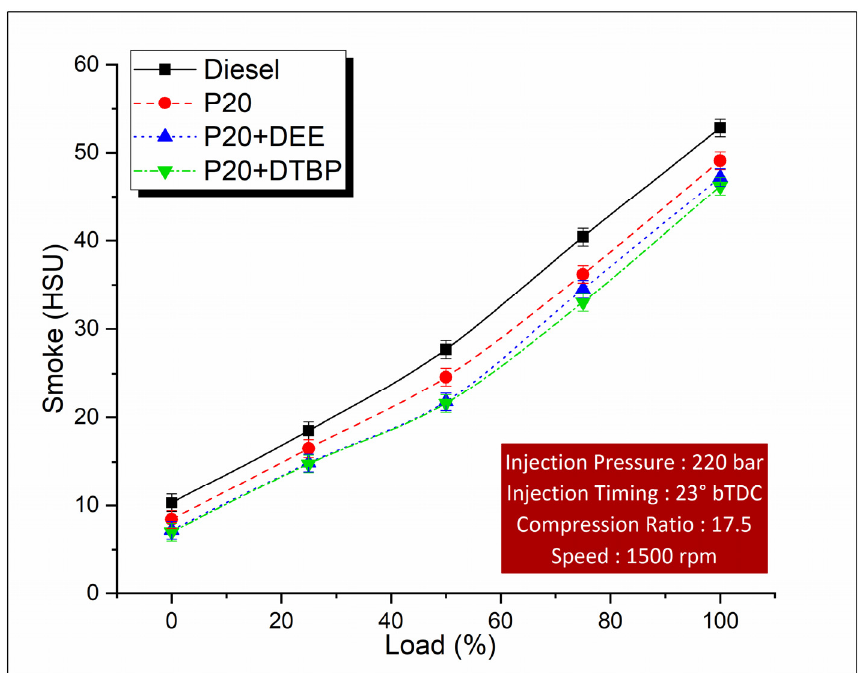
Figure 10. Smoke variation for test fuel blends at full load condition.